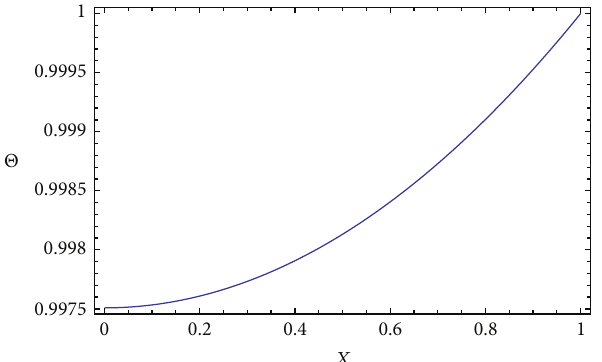
Figure 2: Plot of the asymptotic solution (17) with M = 0.1 and 𝛽 = 𝑛 = 1